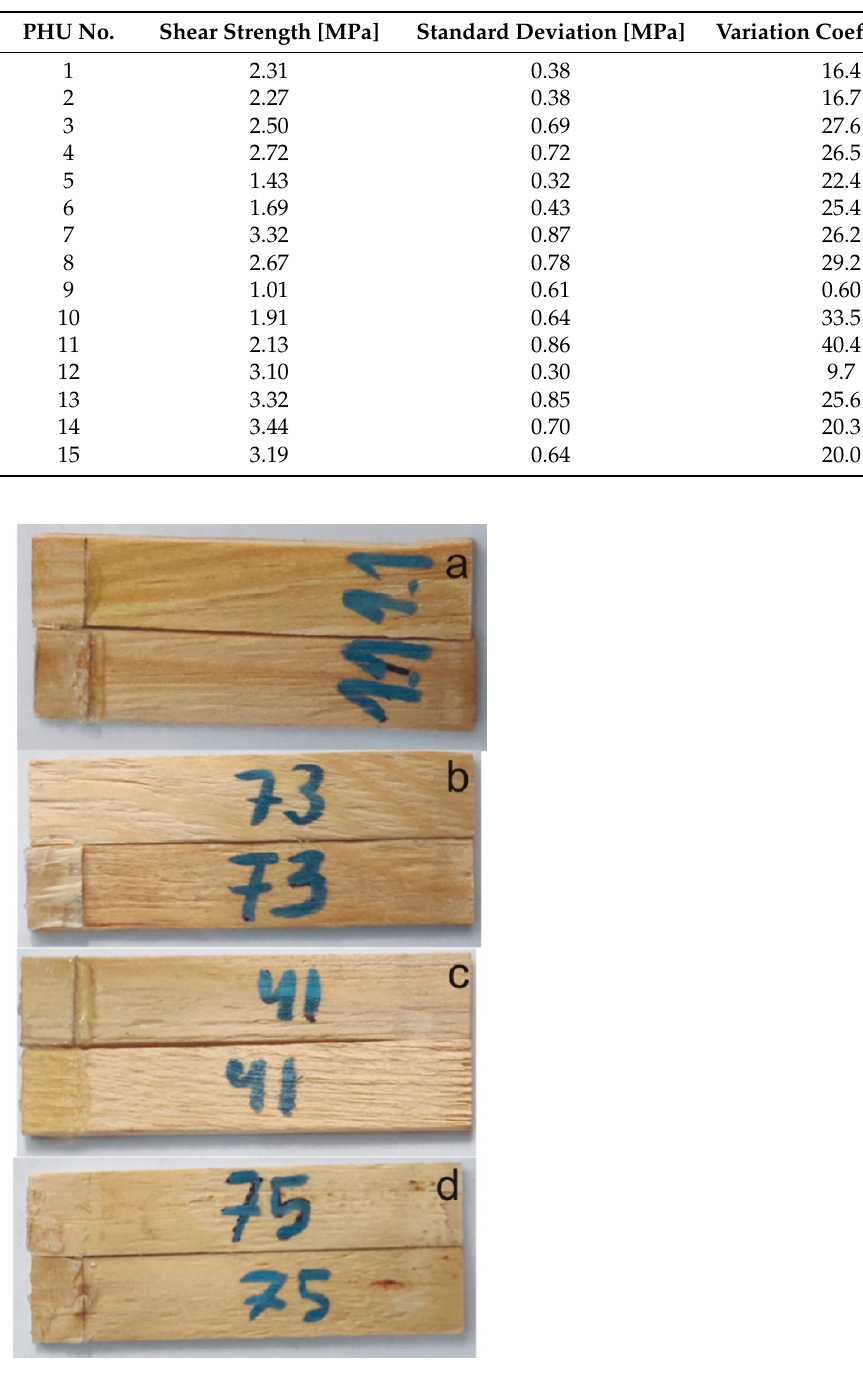
Table 4. Lap shear strengths of PHUs bondlines in pinewood.